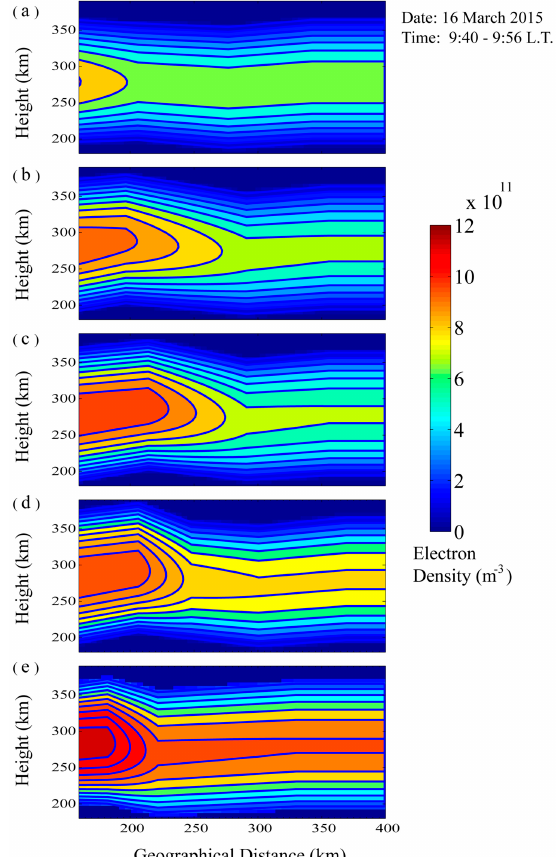
Figure 13. The two-dimensional ionospheric electron density distributing plots of five different directions corresponding to the five beams of the antenna array. The electron density distributing plots ( a – e ) is inverted by the leading edge of the beam of 345°, 330°, 315°, 300°, and 285°, respectively.